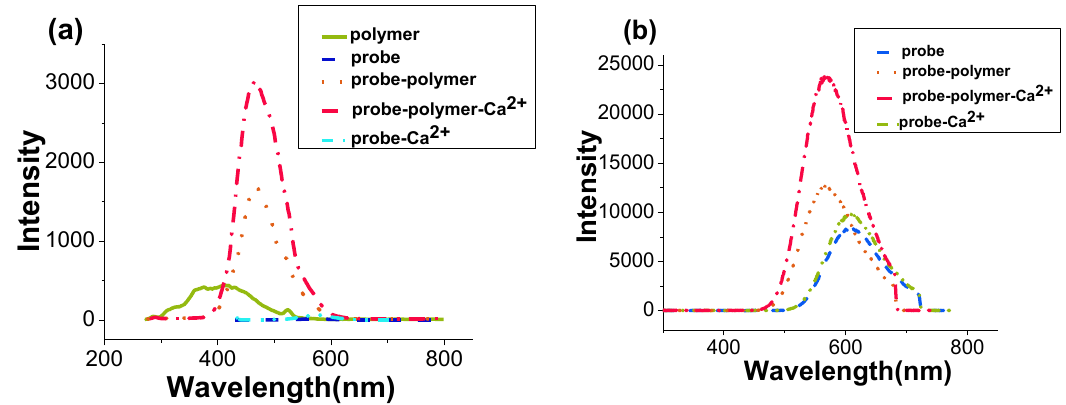
Figure 3. ( a ) One-photon (OP) and( b ) TP fluorescent spectra of different systems. Polymer: PCBMB; probe: BAPTAVP. Table 1. One- and two-photon relative photophysical data and zeta potentials of different systems [a] .